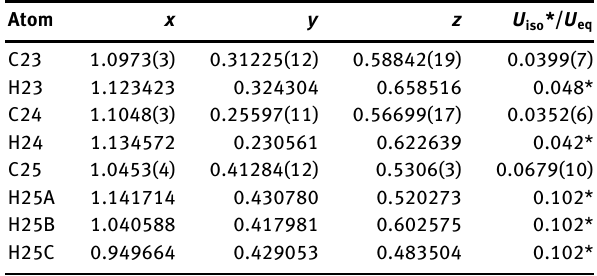
Table 2: Fractional atomic coordinates and isotropic or equivalent isotropic displacement parameters (Å 2